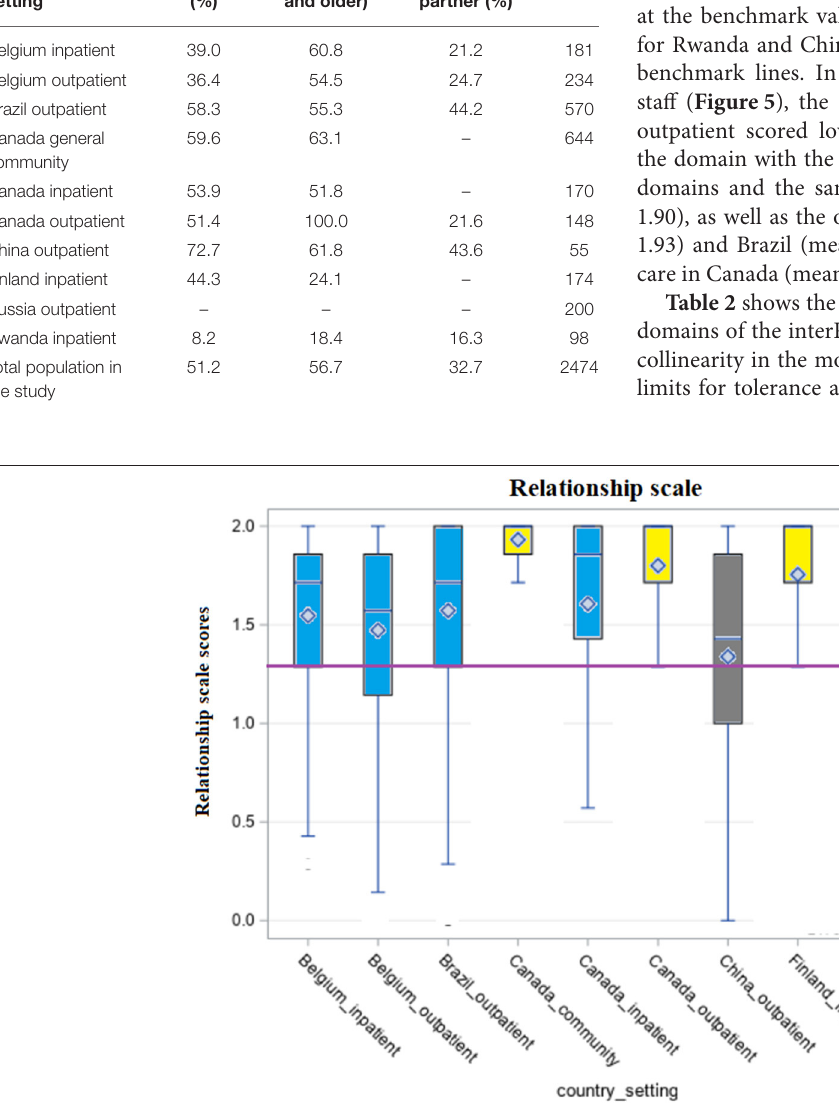
FIGURE 1 | Distribution of scores of the scale “Relationship” across countries and settings.